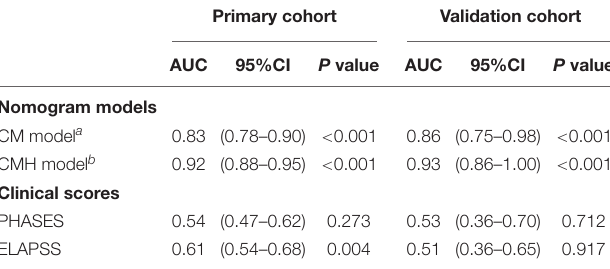
a CM model, clinical and morphological model. b CMH model, clinical, morphological and hemodynamic model. AUC, area under the curve; CI, confidence